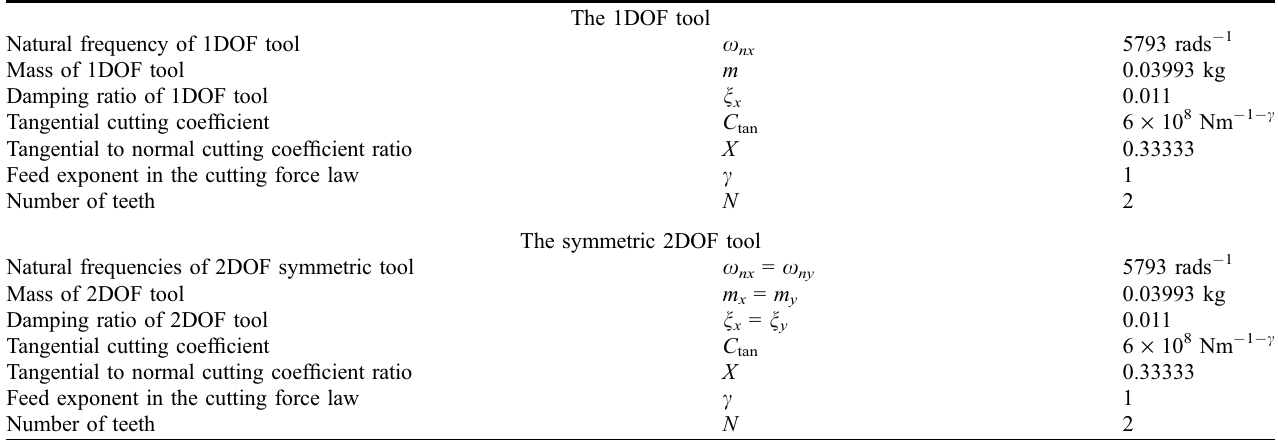
Table 1. Parameters for numerical computations; source